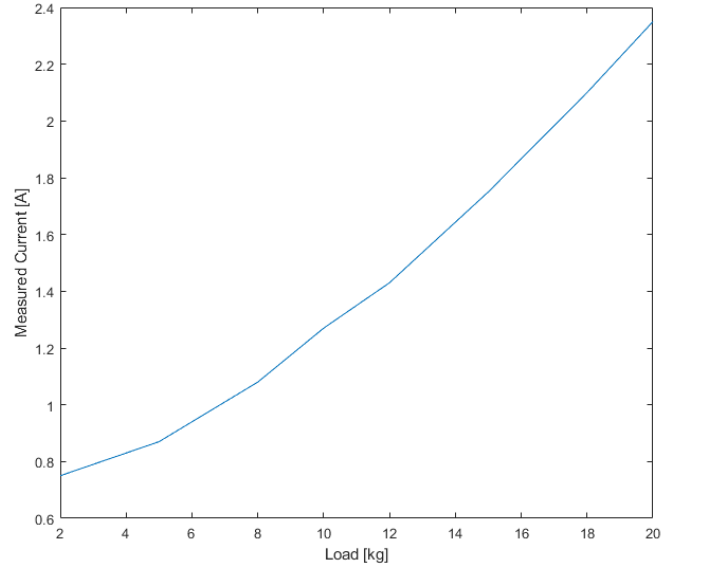
Figure 4. Current consumption vs. load values